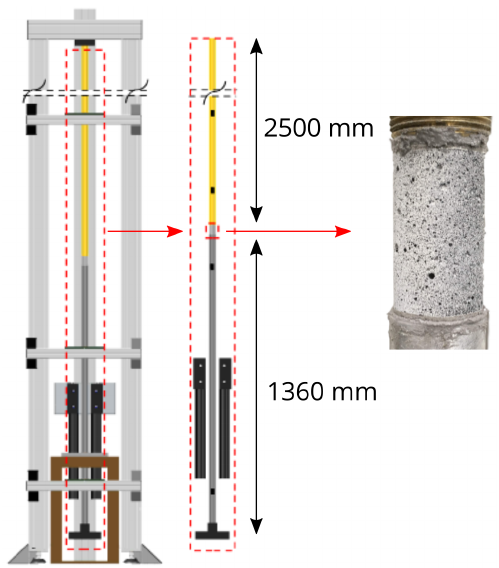
Figure 1. Gravity-driven split-Hopkinson tension bar and cylindrical specimen.